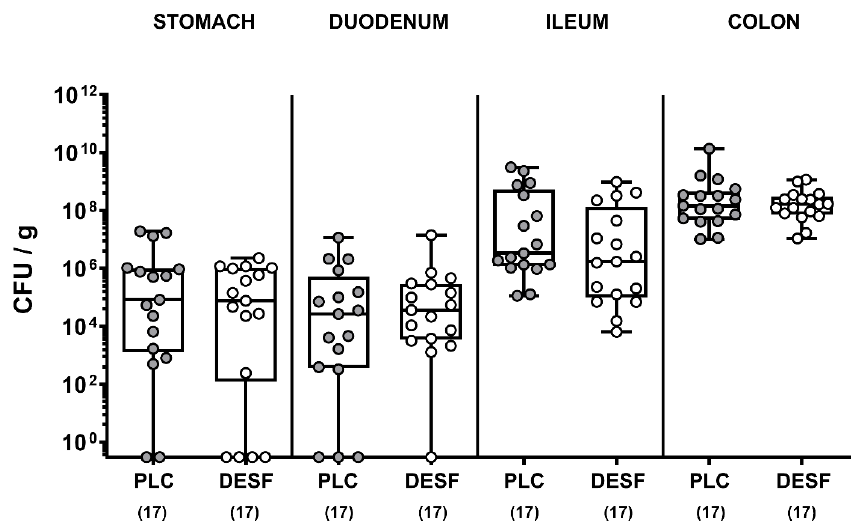
Figure 1. Pathogenic loads in the gastrointestinal tract following C. jejuni infection of microbiota- depleted IL-10 −/− mice that had been pretreated with deferoxamine. Microbiota-depleted IL-10 −/− mice were subjected to desferoxamine (DESF, white circles) pretreatment via the drinking water starting 7 days prior infection or received autoclaved tap water only (PLC; grey circles). On days 0 and 1, mice were perorally infected with C. jejuni strain 81-176 and the luminal pathogen loads (expressed as colony-forming units per gram; CFU/g) were quantitatively assessed in defined parts of the gastrointestinal tract by culture on day 6 post-infection. Whiskers indicating the total range, boxes indicating the 25th and 75th percentiles of the medians (black bars inside boxes), and the total numbers of analyzed mice (in parentheses) are given. Shown data were pooled from three independent experimental sets.